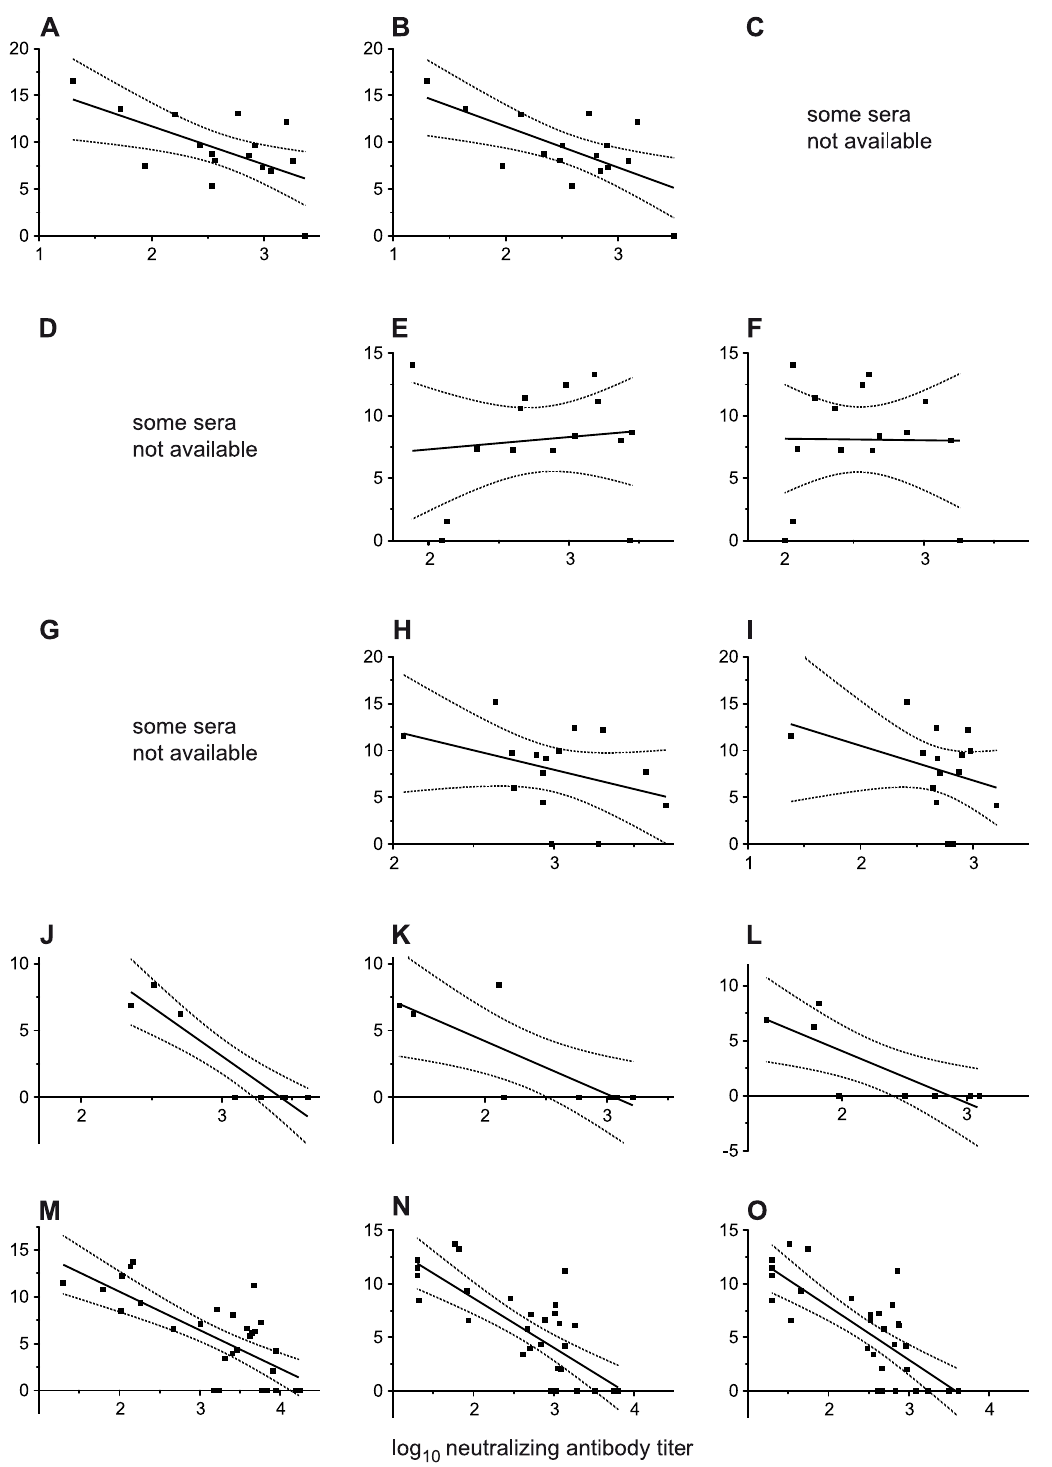
Figure 1. Regression analysis of neutralizing antibody titer with infection after SHIV SF162P4 challenge of immunized rhesus macaques. Macaques are challenged 8 weeks after the final immunization. Neutralizing antibody titer is the dilution of serum which gives a 50% reduction in luciferase production in 1/48/2 TZM-bl cells with SHIV SF162P4 pseudovirus. Infection is quantified as the area under the plot of viral load against time following challenge for individual macaques. Viral load was measured as log 10 RNA equivalents per ml of plasma and time in weeks. Regression lines are presented in the form: y=mx + c where y is the area under the viral load curve, m is the gradient, x is the neutralizing antibody titer and c is the intercept. A , immunization trial 1; 6 weeks before challenge. Spearman r= 2 0.5324, p=0.0338. m= 2 4.090 6 1.417, c=19.90 6 3.776, r 2 =0.3729, p=0.0120. B , immunization trial 1; 2 weeks before challenge. Spearman r= 2 0.4912 p=0.0534. m= 2 4.380 6 1.370, c=20.46 6 3.588, r 2 =0.4221, p=0.0065. C , immunization trial 1; sera from some macaques not available at challenge. D , immunization trial 2; sera from some